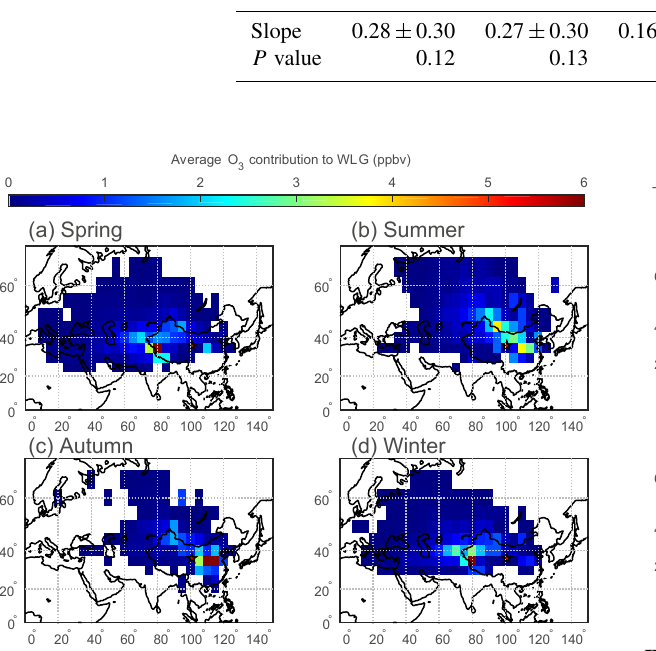
Figure 9. Average seasonal distributions of the trend of ozone con- tribution to WLG through direct transport of ozone during 1994– 2013; grey dots stand for the grid cells with p < 0 .